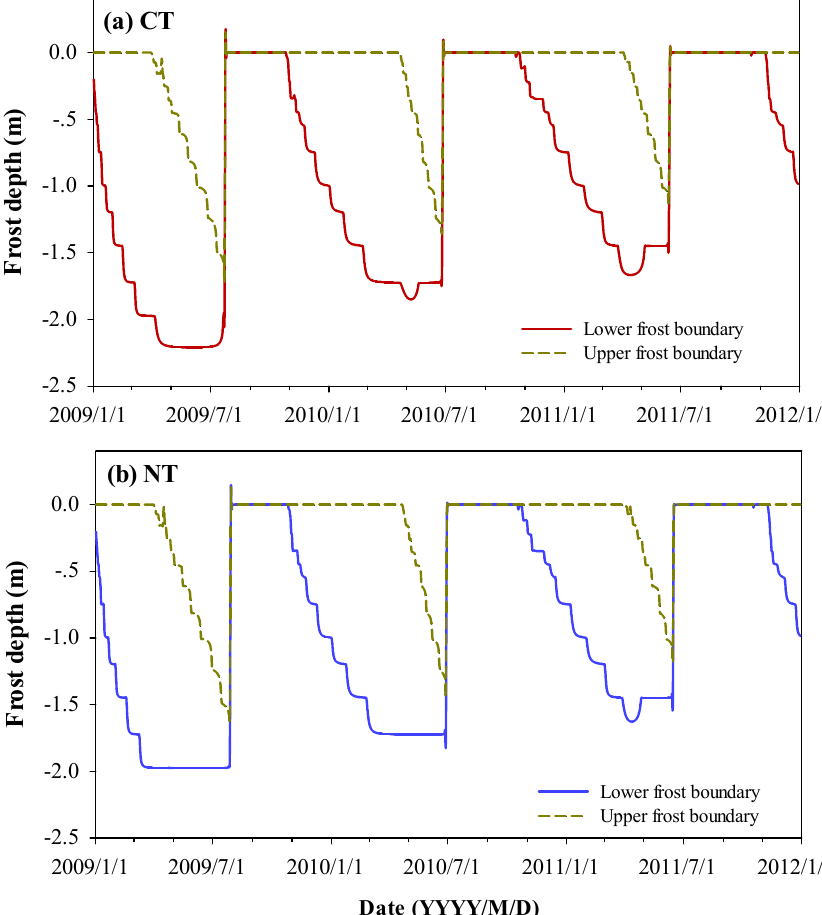
Figure 8. Simulated upper and lower boundaries of frost depth for ( a ) and ( b ) during 2009–2011.